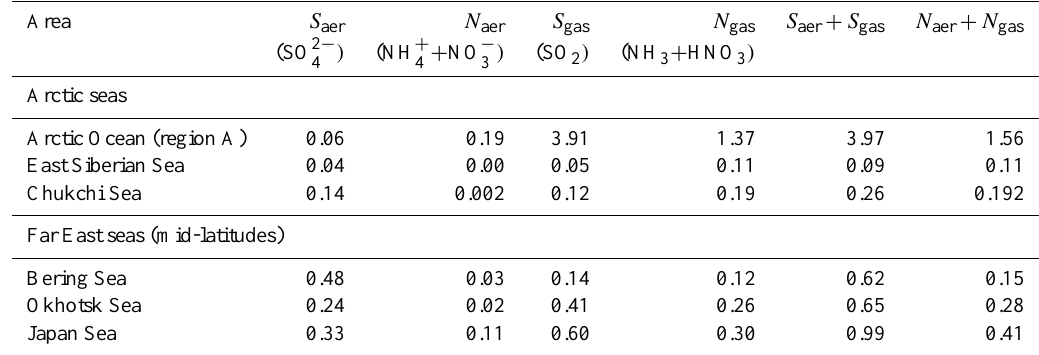
Table 10. Diurnally average vertical fluxes of sulfur and nitrogen together with aerosol and gas-phase species (mgm − 2 day − 1 ) according to data of measurements in Arctic and Far East seas (RV Akademik Fedorov and Professor Khljustin ).